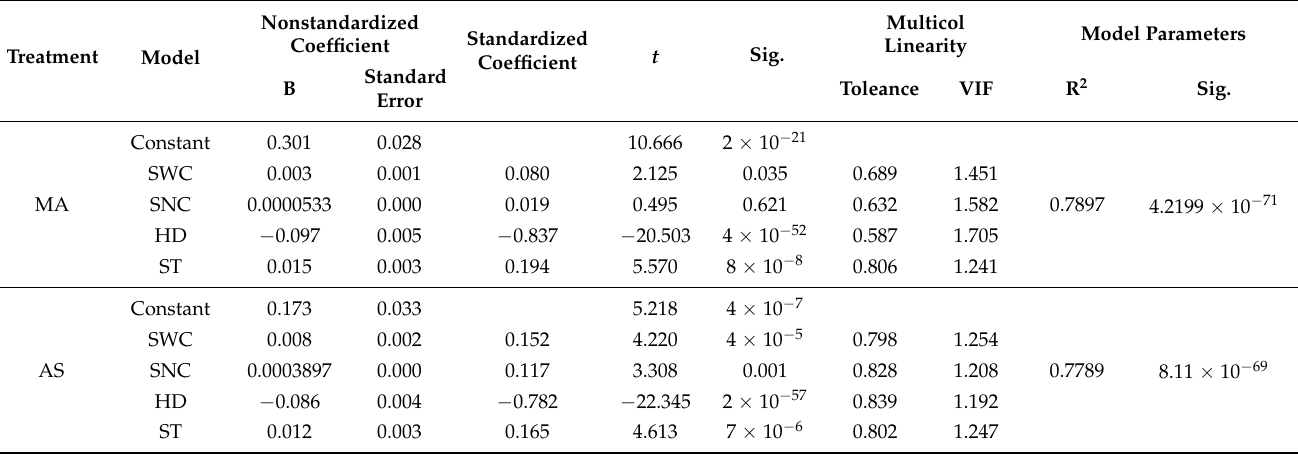
Table 2. Results of multiple linear regression analysis of fine root density and different influencing